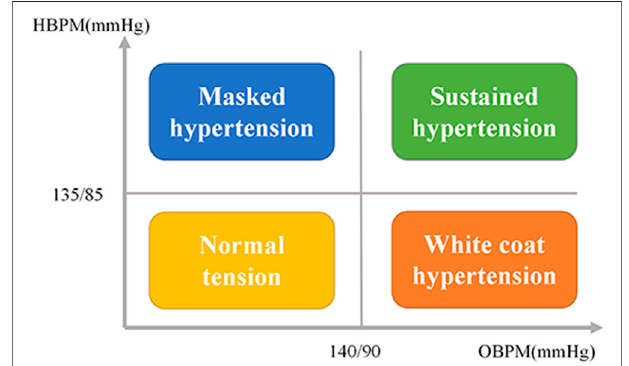
FIGURE 1 | The classi fi cation of BP subtypes by combination of of fi ce and home BP readings. BPM = Home blood pressure monitoring; OBPM = Of fi ce blood pressure monitoring; BP = Blood